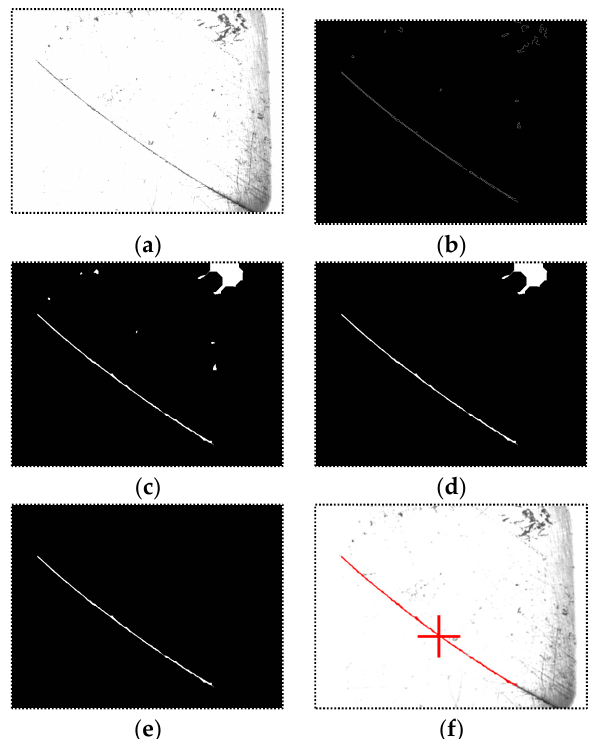
Figure 11. The processing result of each step of the narrow butt detection algorithm. ( a ) The original captured image; ( b ) The image after the Canny operator is applied; ( c ) The image after morphological closing operation; ( d ) The image after connected domain extraction and thresholding based on domain area; ( e ) The image after domain selection according to area-to-perimeter ratio; ( f ) The image after groove center calculation. The final detected results are marked as red curve.